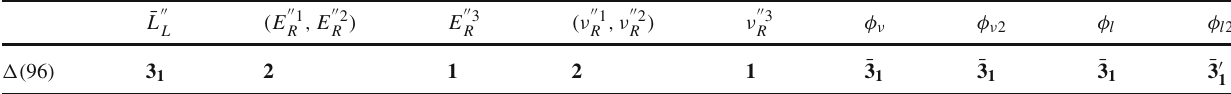
Table 5 Relevant field and (cid:2)( 96 ) symmetry